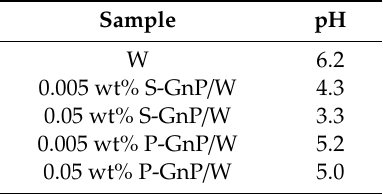
Table 2. pH values of the different-loaded nanofluids at room temperature.